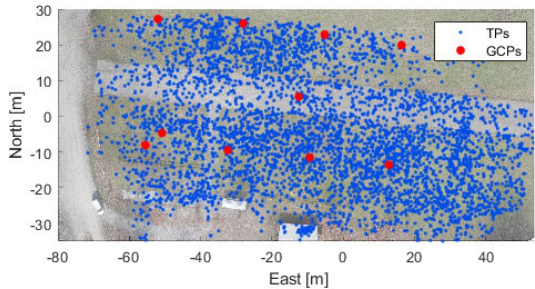
Figure 3. Flight trajectory of Flight C , employed for calibrating the system. Red dots denote shot positions.